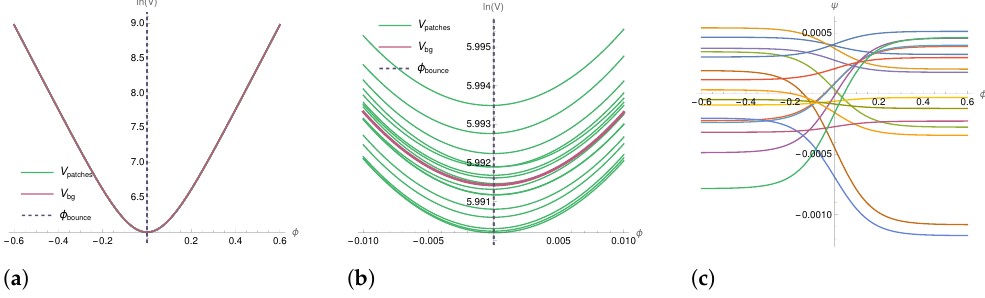
Figure A1. The evolution of the expectation value of the volume operator for Fock coherent states V ( φ ) = (cid:104) σ | ˆ V ( φ ) | σ (cid:105) and the resulting dynamics for ψ in an example ensemble with N patches = 16 and different values of A p , B p in each patch. v 0 = 1. ( a ) Evolution of the volume in each patch and the background (average) volume V bg . ( b ) The evolution of the volume of each patch and V bg close to the bounce. The minimum volume is reached at a different value of φ in each patch. ( c ) Evolution of ψ (41) as determined by V p and V bg for all patches. The values in different patches (generated from a white noise process) are given in the table below. Note that the behaviour presented above is generic and the specific values are only reported for